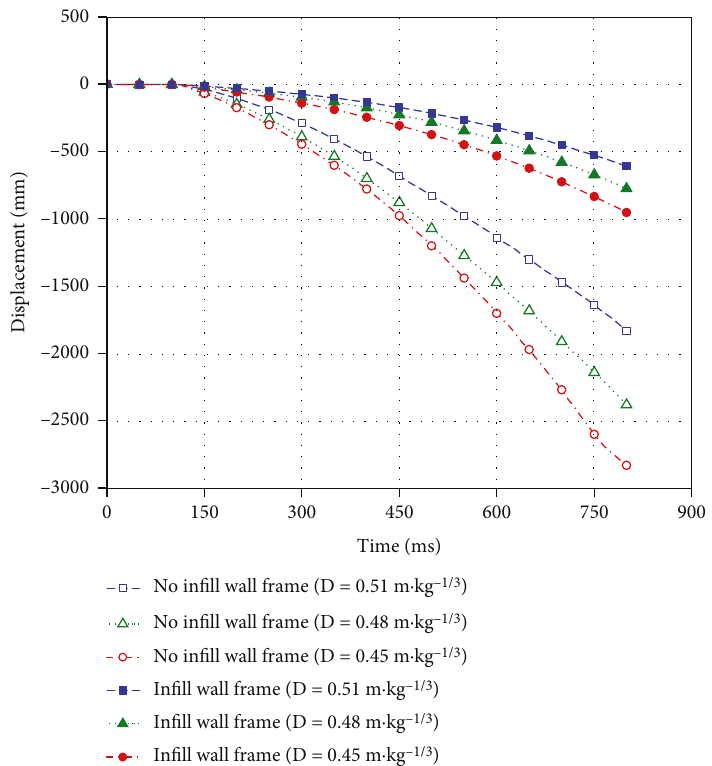
Figure 6: The z -directional displacement of the apex of the column in the third fl oor